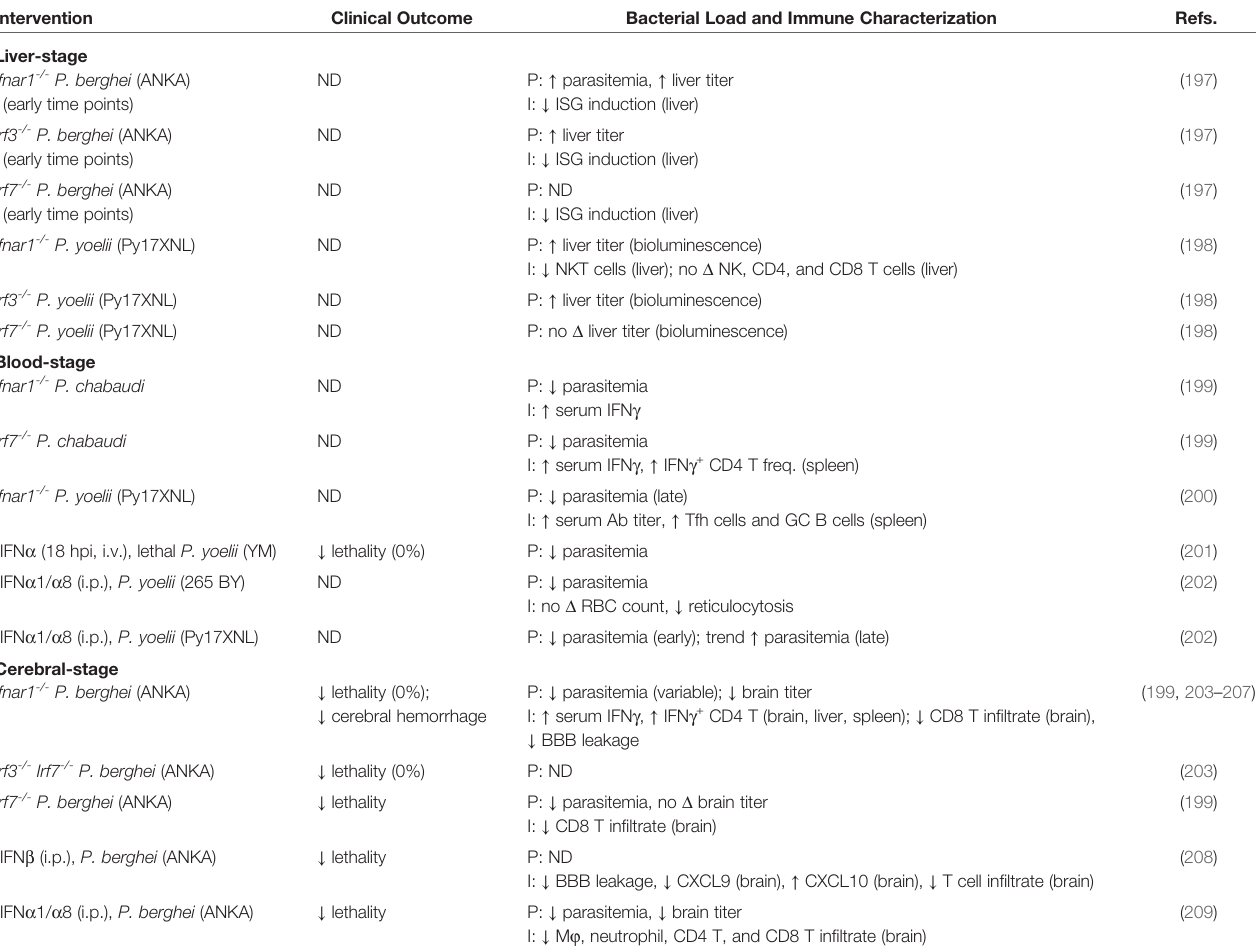
TABLE 3 | Summary of IFN a and IFN b functions in mouse models of malaria infection. Intervention Clinical Outcome Bacterial Load and Immune